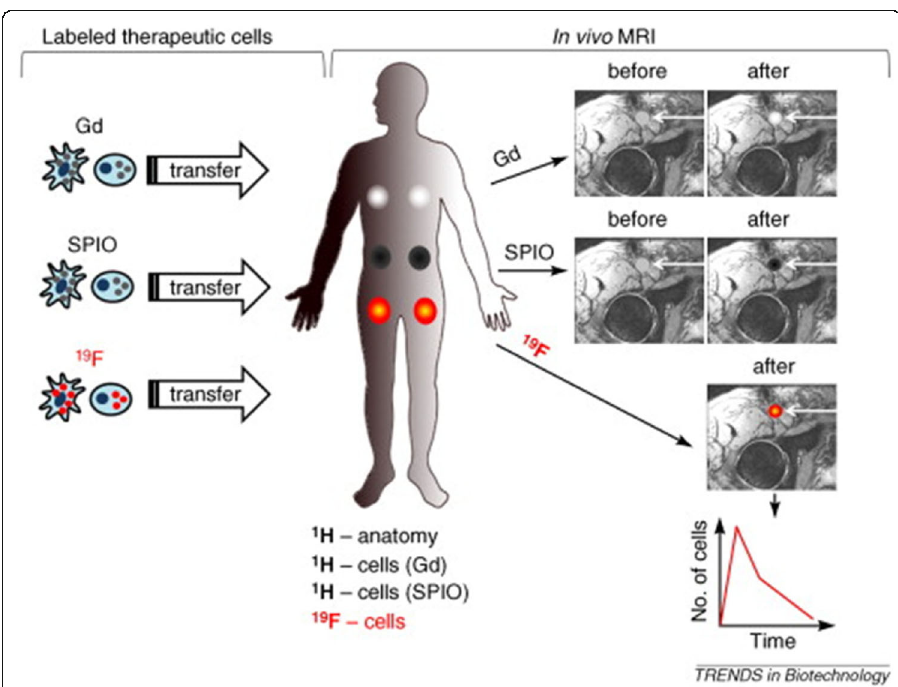
Fig. 4 Cell tracking using MRI with contrast agents and 19 F labels. Therapeutic cells (e.g. dendritic cells or stem cells) are labeled using contrast agents (Gd or SPIO), or a 19 F label. Conversely, typical anatomical MRI utilizes the 1 H from H 2 O in tissues. Labeled cells are transferred to the patient by localized transfers, including intradermal or intranodal injections; the patient is then imaged to determine cell localization. Gd and SPIO (superparamagnetic iron oxide) labels typically require “ before ” and “ after ” images for localization (white arrows), resulting in a final hyperintense or hypointense spot signal, respectively. With a 19 F label, imaging can be carried out in a longitudinal manner for 19 F (specifically the labeled cells) and 1 H (anatomy) without a “ before ” image. Furthermore, the total 19 F signal can be calculated from the in vivo data, providing tracking information for both the localization and number of cells. Such quantitative, unambiguous cell tracking is not possible using standard imaging techniques in conjunction with metal- based contrast agents (Srinivas et al.